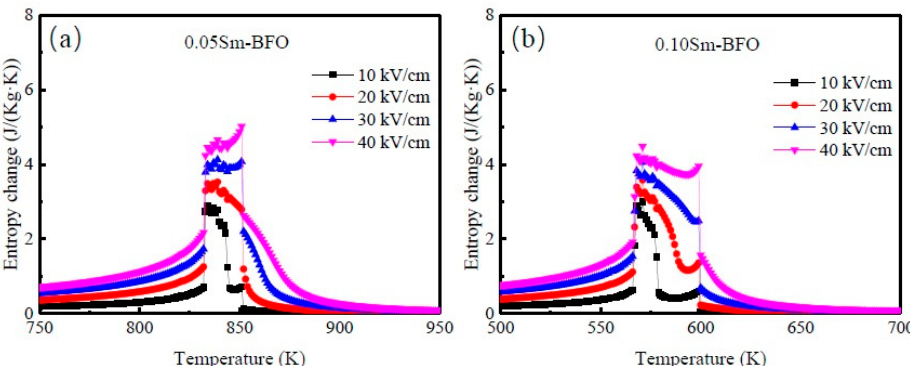
Figure 3. Entropy changes of ( a ) 0.05 Sm-BFO (BiFeO 3 ) and ( b ) 0.10 Sm-BFO as a function of temperature under different electric fields of 10, 20, 30, and 40 kV/cm. under di ff erent electric fields of 10, 20, 30, and 40 kV / cm.